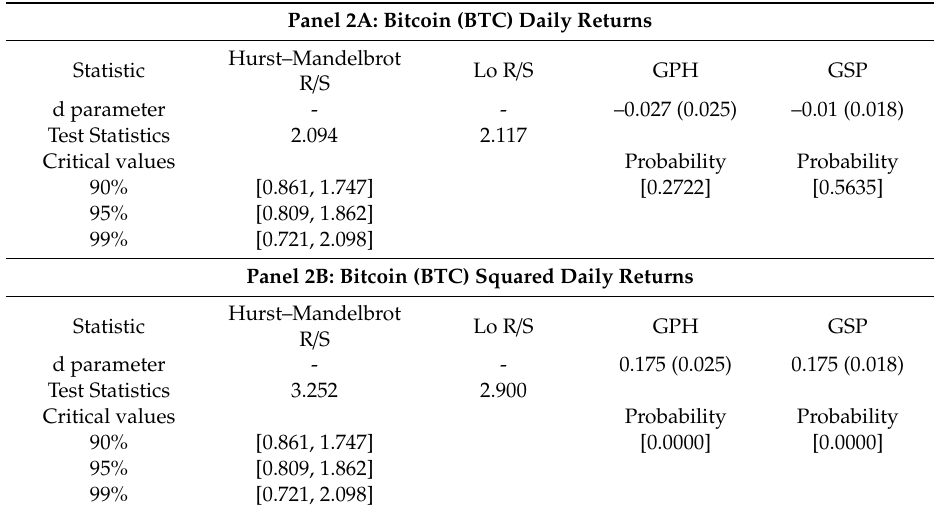
Table 2. Long Memory Tests for Bitcoin (BTC) Return and Squared